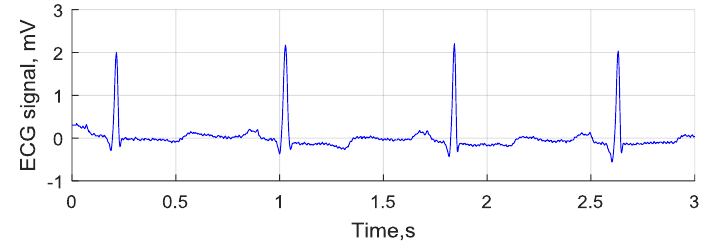
Figure 9. ECG signal recorded using the developed board.